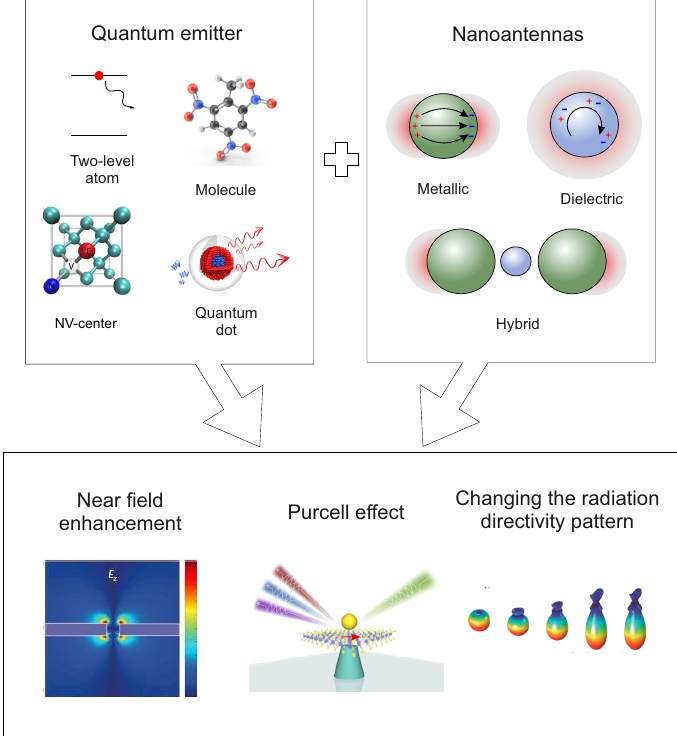
Figure 1. Properties of nanoantennas for controlling the electromagnetic field at the nanoscale and changes in the parameters of spontaneous radiation of a QE in the near field of a